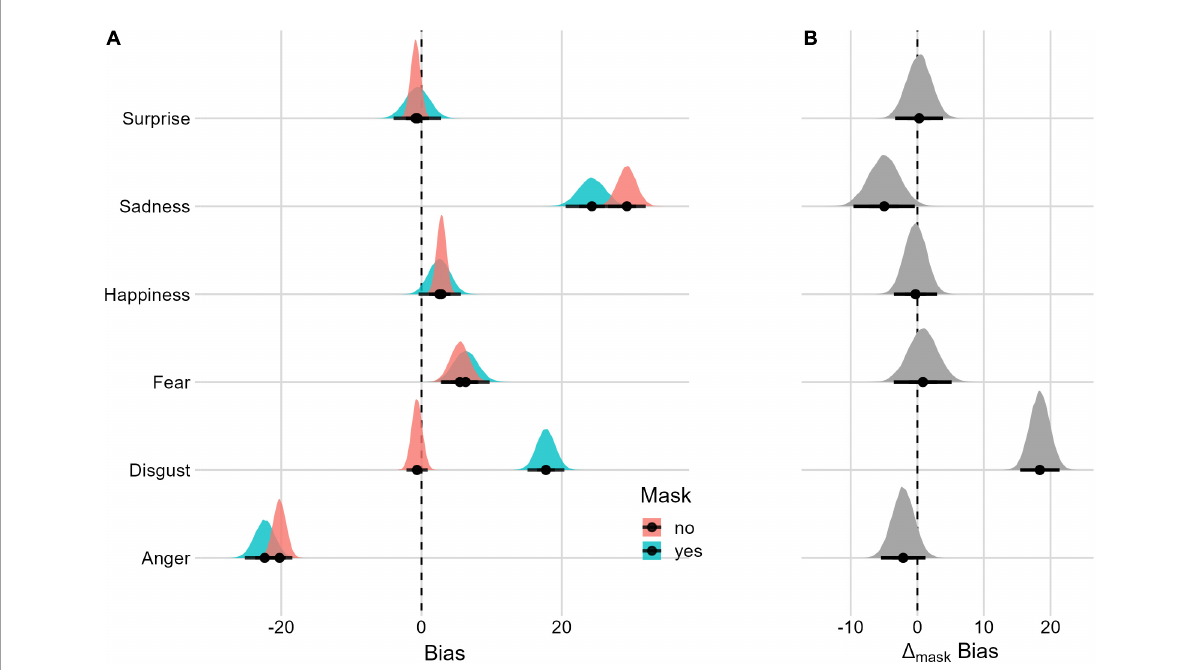
FIGURE3 Posterior distributions and 95% HPDIs of the bias Mask effect (A) Bias posterior distributions as a function of the Mask condition. (B) Posterior distributions of the Mask (cid:49) contrast (Mask yes –Mask no ).